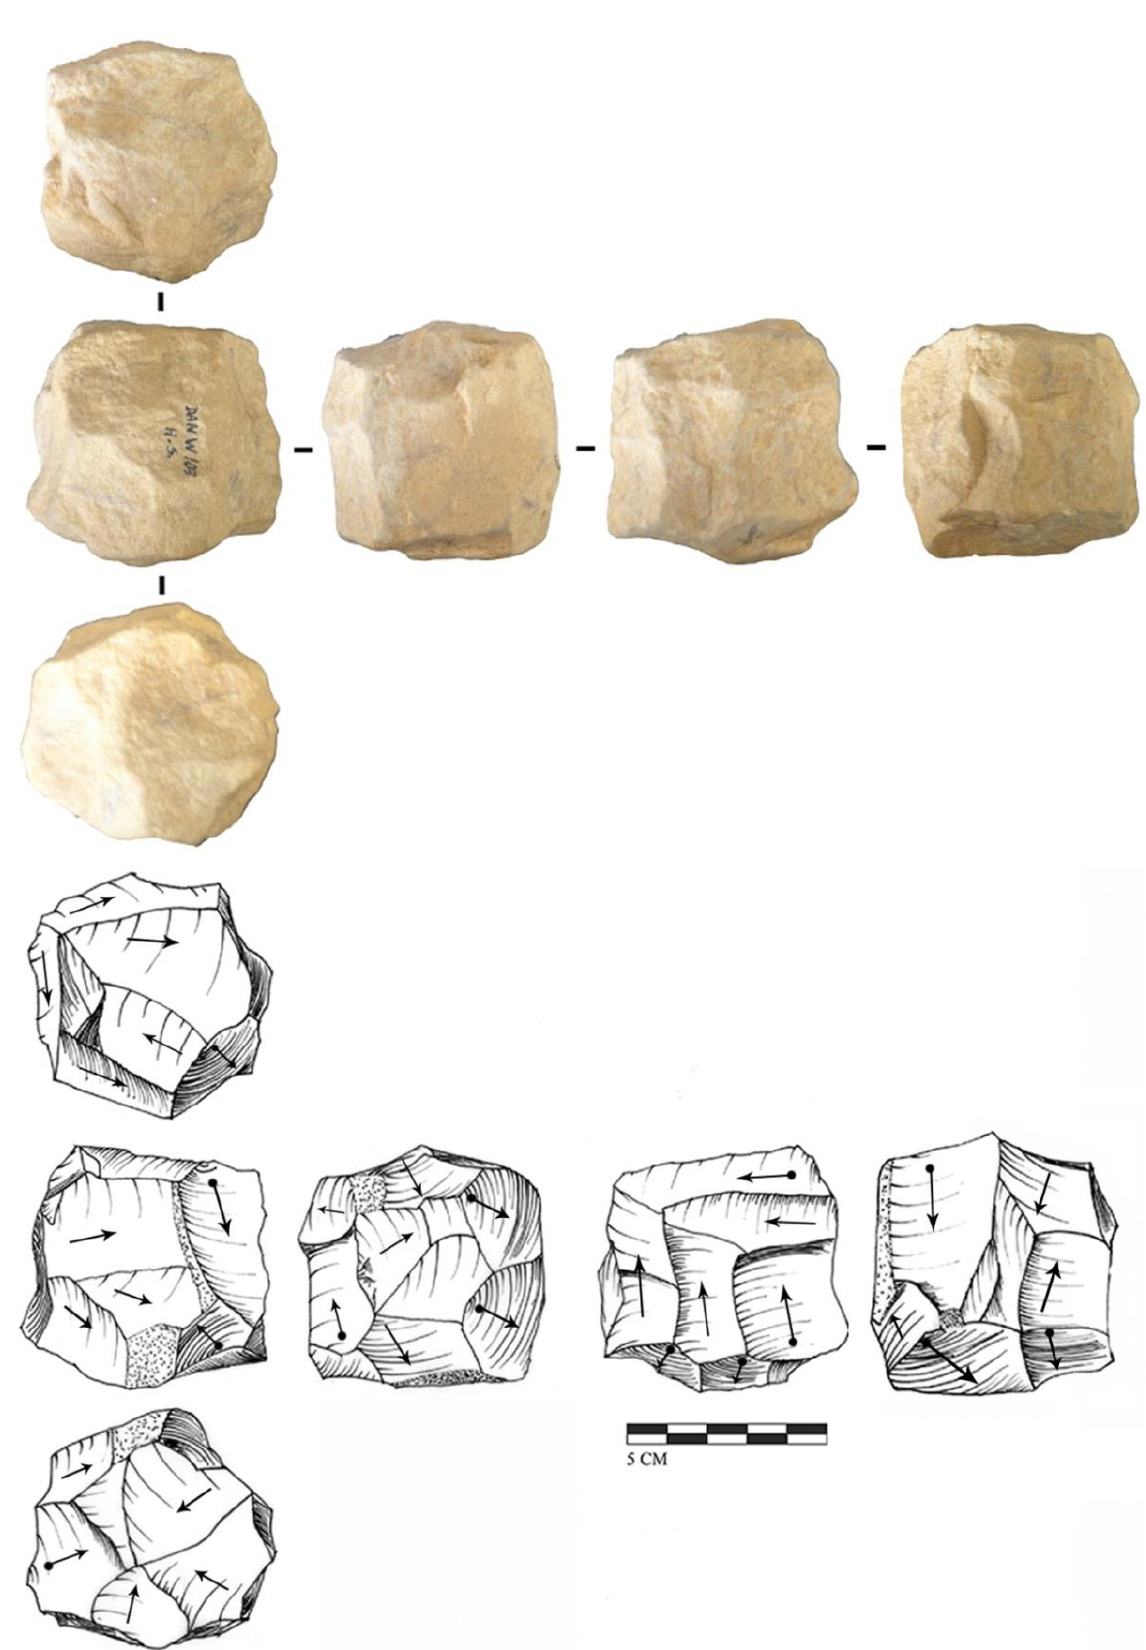
Figure 8. Core polyhedron. Quadrangular flake production on all faces of the